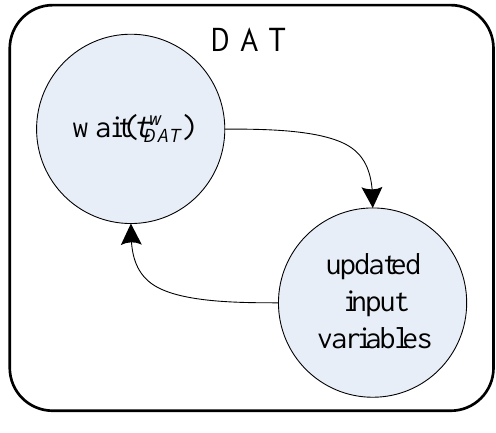
Figure 4. Finite automata associated with DAT.